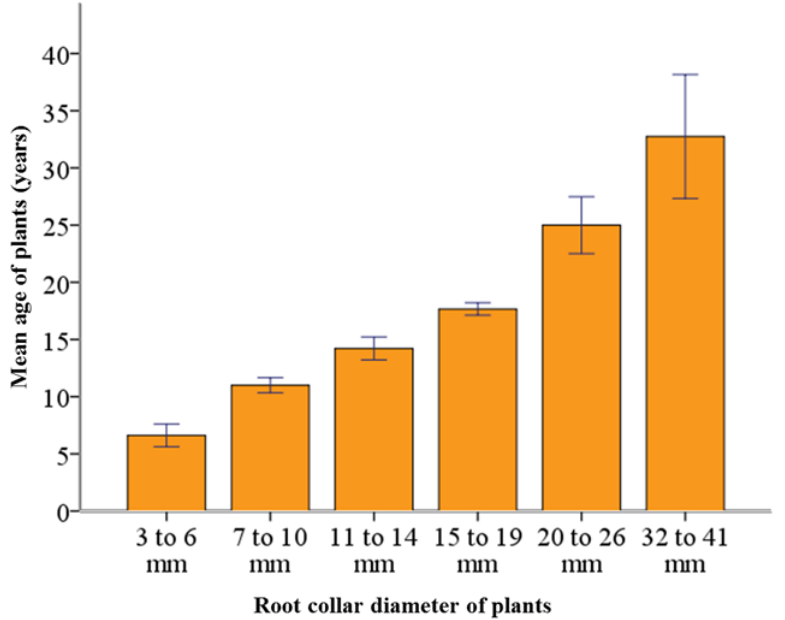
Figure 5. Age and root collar diameter of sampled beech plants (N = 42). Thin bars represent the standard error of mean at a 95% confidence